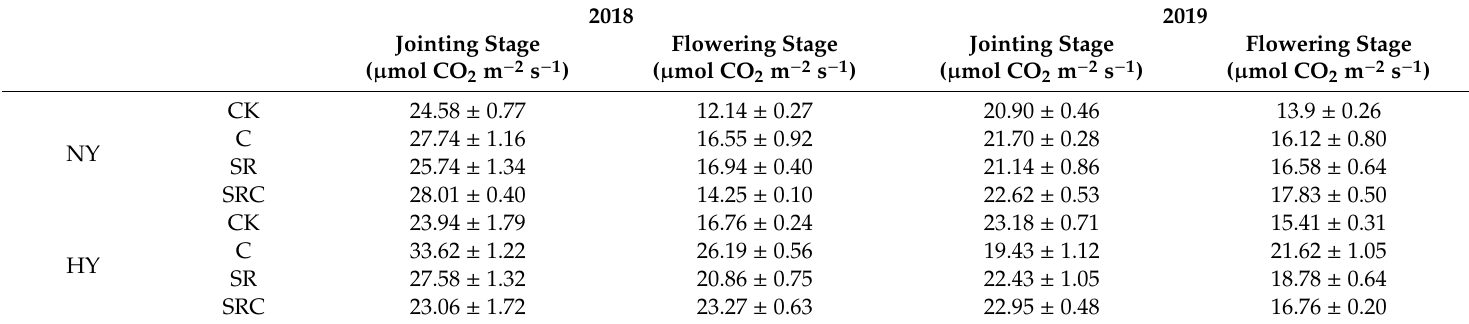
Table 6. E ff ects of biochar and soft rock treatments on the photosynthetic rate in two fertilizer